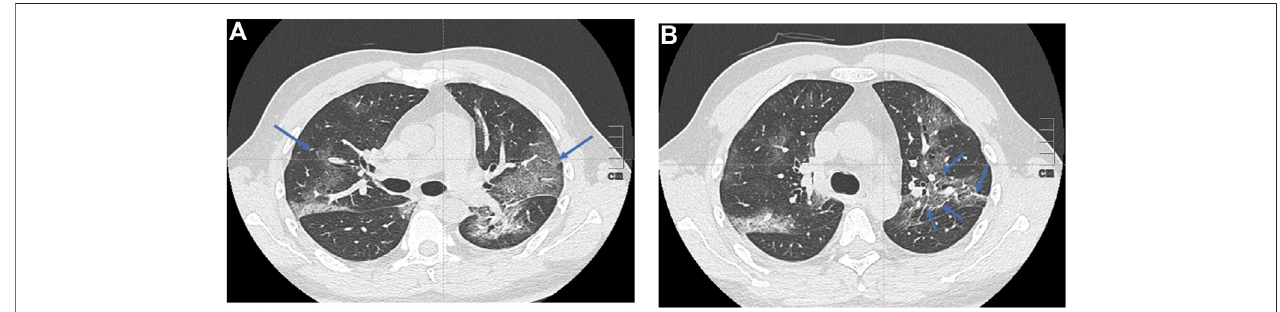
FIGURE 1 | Chest computed tomography images of patients with COVID-19 pneumonia (A) shows Ground-glass opacities (blue arrows) (B) shows con fl uent crazy-paving pattern and consolidation opacities: secondary appearance of intralobular reticulations (blue arrows).